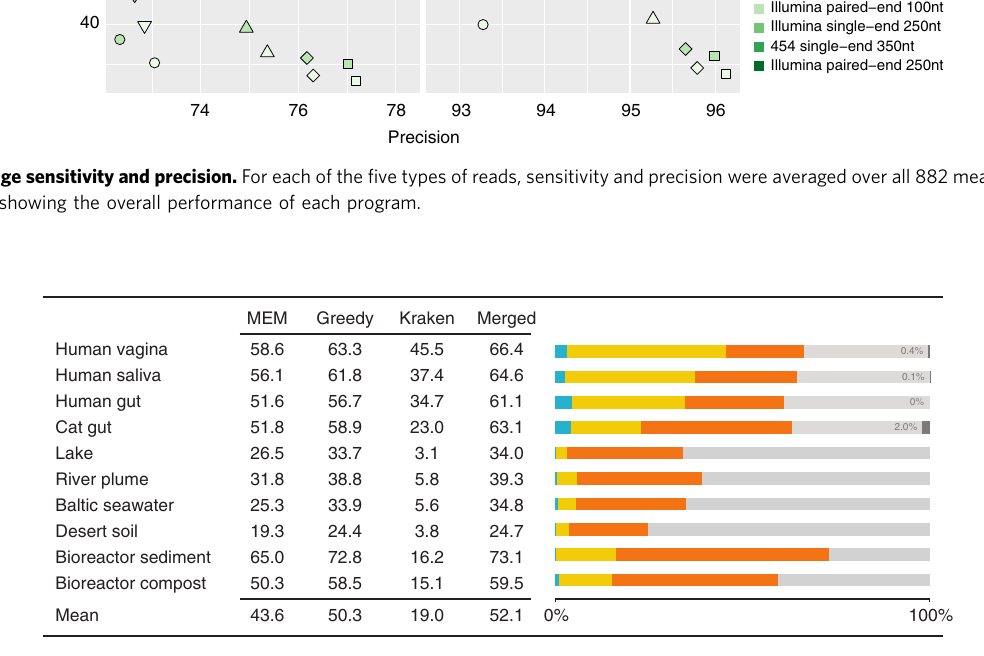
Figure 3 | Classification of real metagenomes. Percentage of classified reads in 10 real metagenomes for Kaiju MEM ( m ¼ 12) and Greedy-5 ( s ¼ 70), as well as Kraken ( k ¼ 31). The Merged column shows the percentage of reads that are classified by at least one of Greedy-5 or Kraken. The Venn-Bar-diagram visualizes the percentage of reads that are classified either only by Kraken (blue), Greedy-5 (orange) or both (yellow). Grey bars in the human and cat samples denote the percentage of reads mapped to the respective host